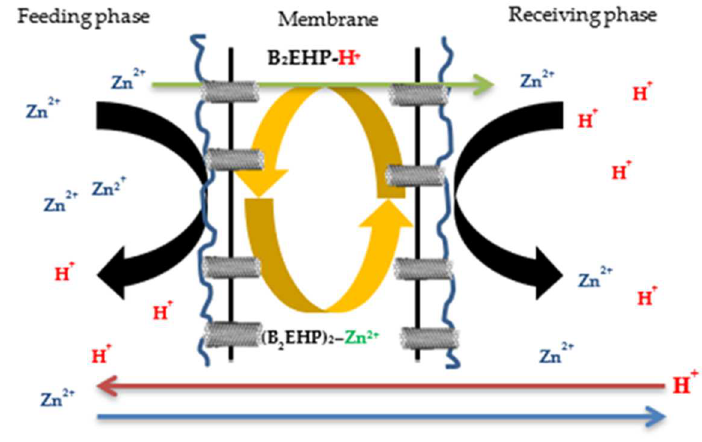
Figure 15. Illustrations of zinc (II) ion extraction process.